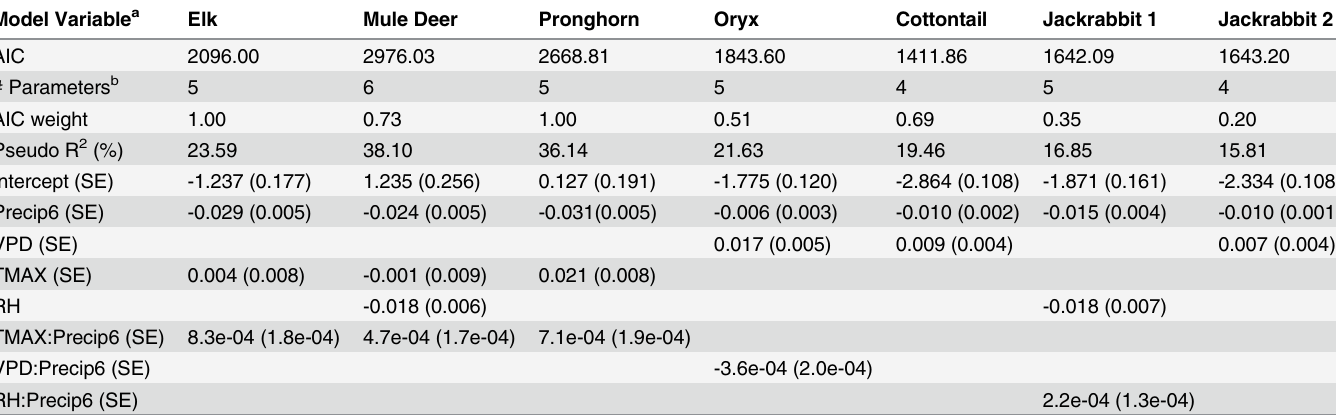
Table 2. Herbivore Visitation.